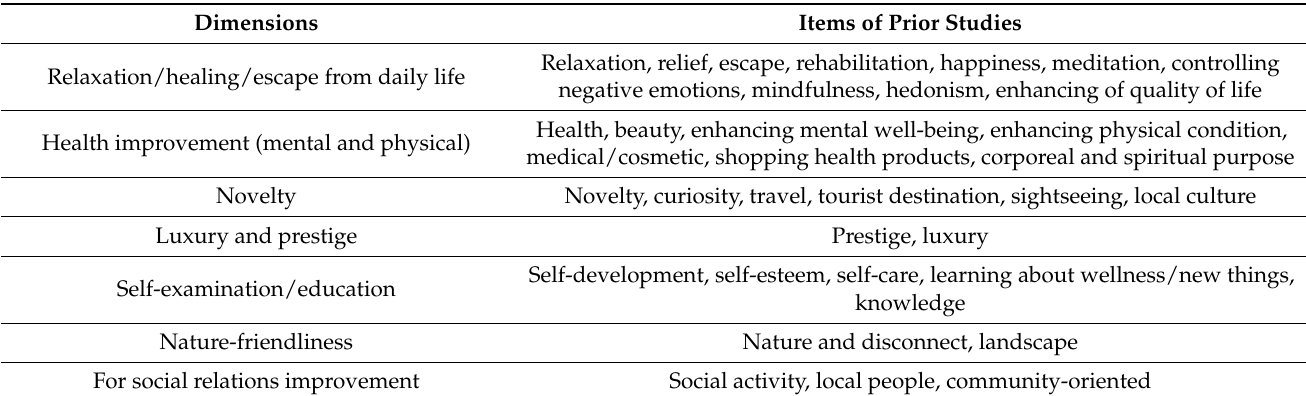
Table 3. Motivations for participation in wellness